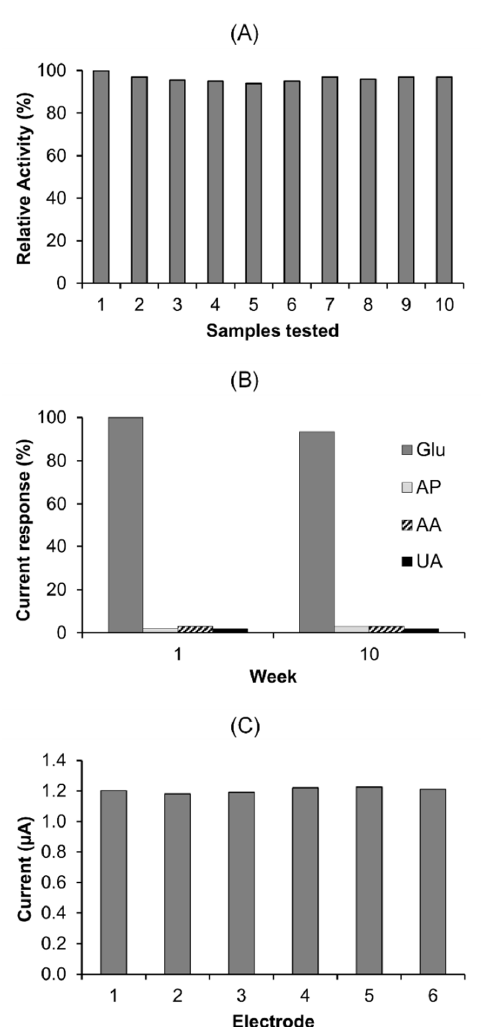
Figure 8. Reusability : Amperometric responses of a Au-MPTS-Pt sensor to ten 1 mM glucose samples in 0.1 M PBS at the applied potential of 0.4 V ( A ). Stability : Amperometric responses of the Au- MPTS-Pt to additions of 1 mM glucose and 0.1 M interferences in 0.1 M PBS at week 1 and week 10 ( B ). Reproducibility : Amperometric responses of six independently fabricated Au-MPTS-Pt sensors to additions of 1 mM glucose in 0.1 M PBS ( C